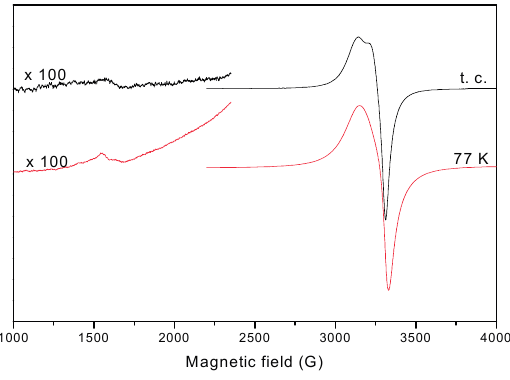
Figure 13. EPR spectrum of the complex 4 , in solution, at room temperature and 77